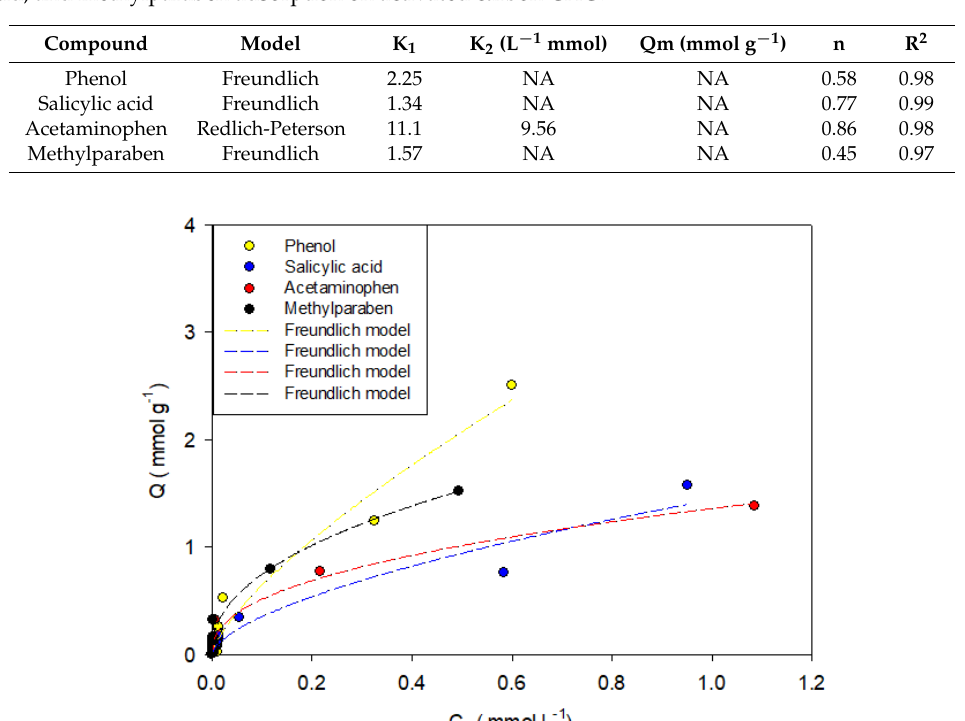
Figure 5. Adsorption isotherm of phenol, acetaminophen, salicylic acid, and methylparaben on activated carbon CAR1073 at 293 K.